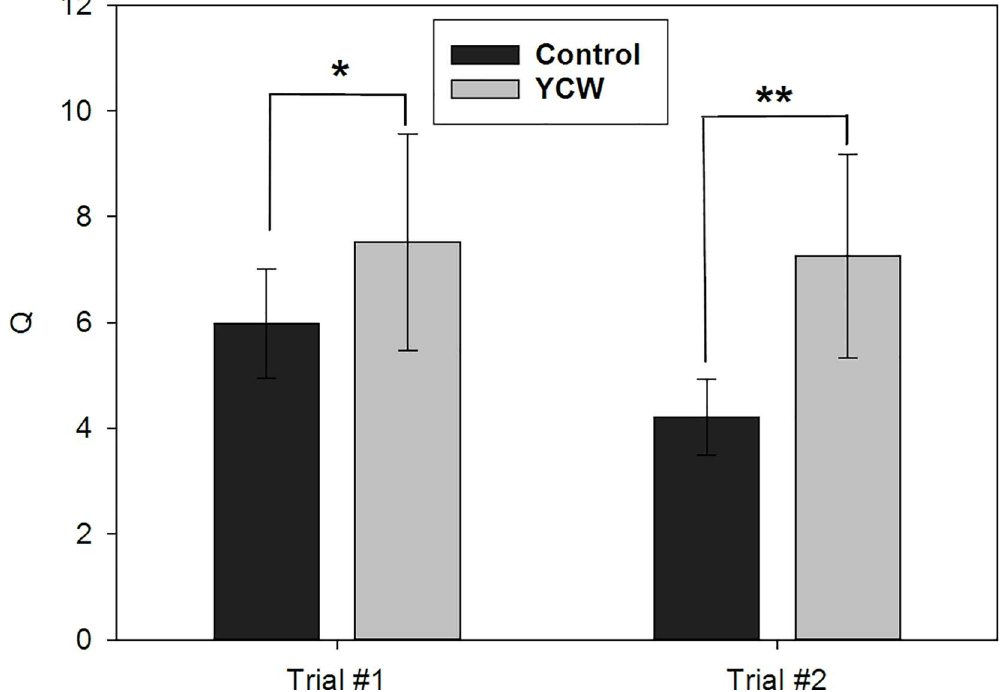
Fig 4. Effect of dietary YCW extractson calrl expression in the skin of Atlantic salmon during two independent feeding trials. Fish were fed either a control diet (Control) or the same base diet supplemented with 0.4% YCW for 4–7 weeks. Expression is given as a ratio of the arbitrary unit for calrl to the arbitrary units of two reference genes, elongationfactor 1-alphaand beta-actin.Data are present as Means ± SEM (n = 9). Statistical significancewas calculatedby independentsample t-test, after checkingfor normalityand outliers. One star ( * ) denotesp < 0.10and two stars ( ** ) denotesp <